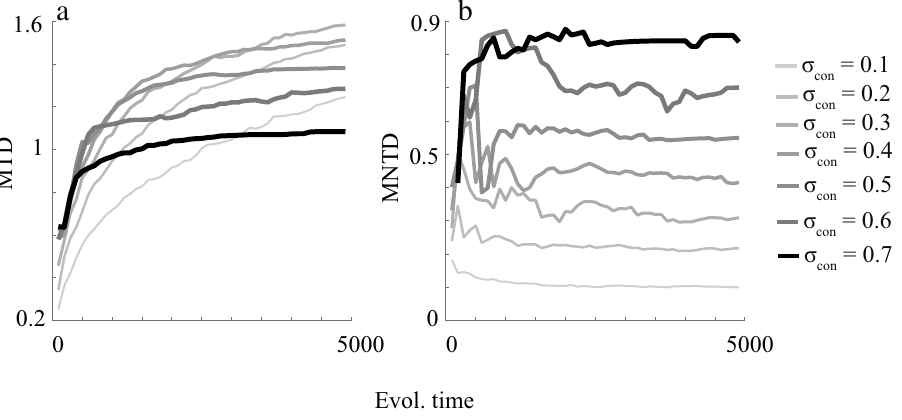
Figure 5. Mean trait distance (MTD) ( a ) and mean nearest trait distance (MNTD) ( b ) as a function of evolutionary time and niche widths (σ con ). All results are shown as means over 20 simulation replicates. Model parameters that were kept constant for the simulations were: K 0 = 10,000; σ K = 1; r = 1; µ = 0.01; σ µ = 0.02. Figure produced in MATLAB version